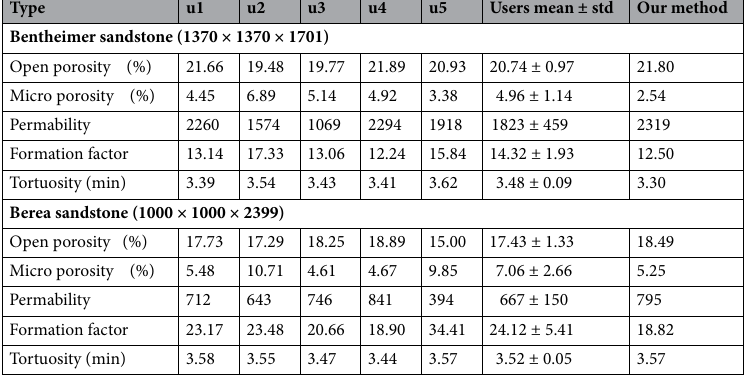
Table 4. Comparison of petrophysical properties between our method and human-assisted segmentations.